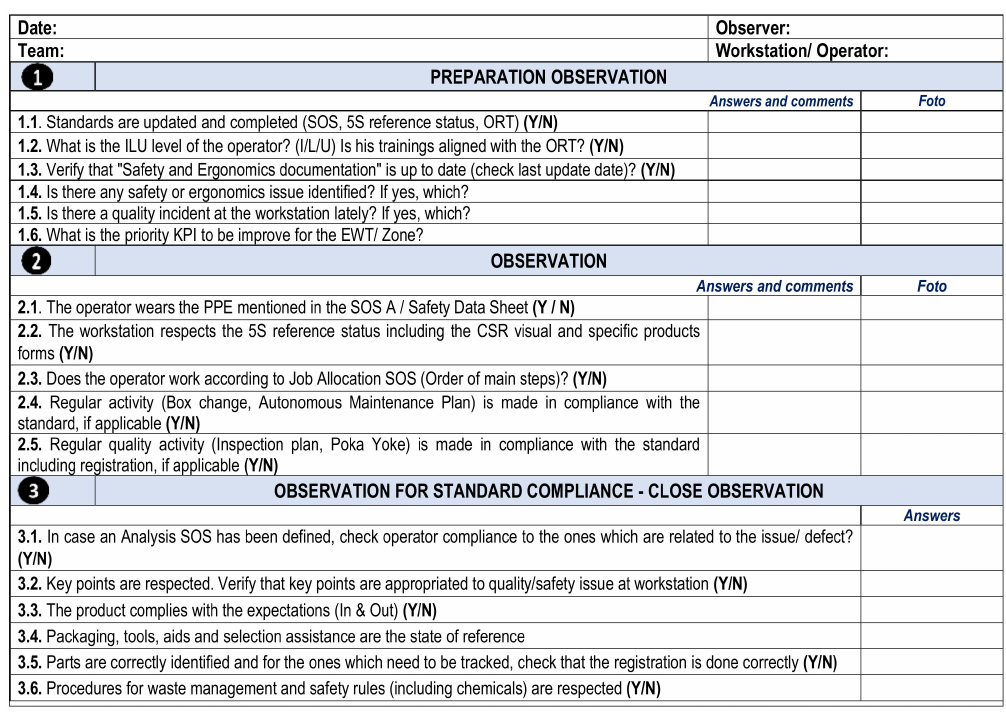
Figure 6. JobObservation